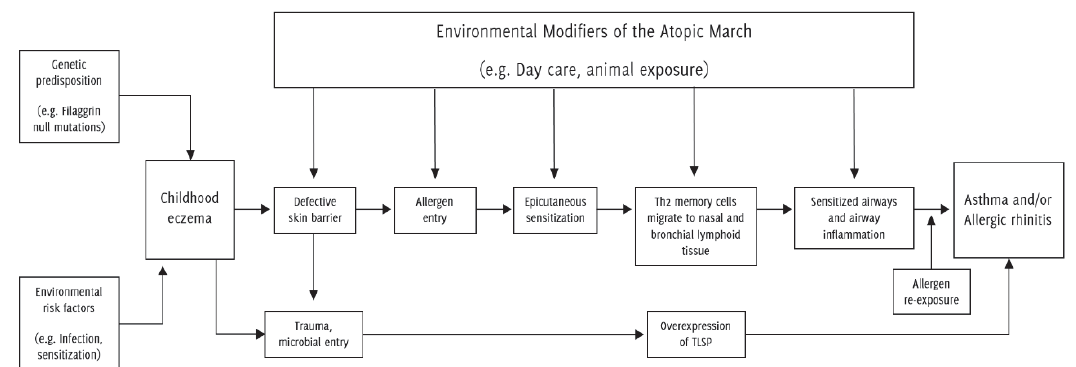
Source: Dharmage SC, Lowe AJ, Matheson MC, Burgess JA, Allen KJ, Abramson MJ. Atopic dermatitis and the atopic march revisited. Allergy. 2014 Jan;69(1):17-27. Reprinted with permission from John Wiley and